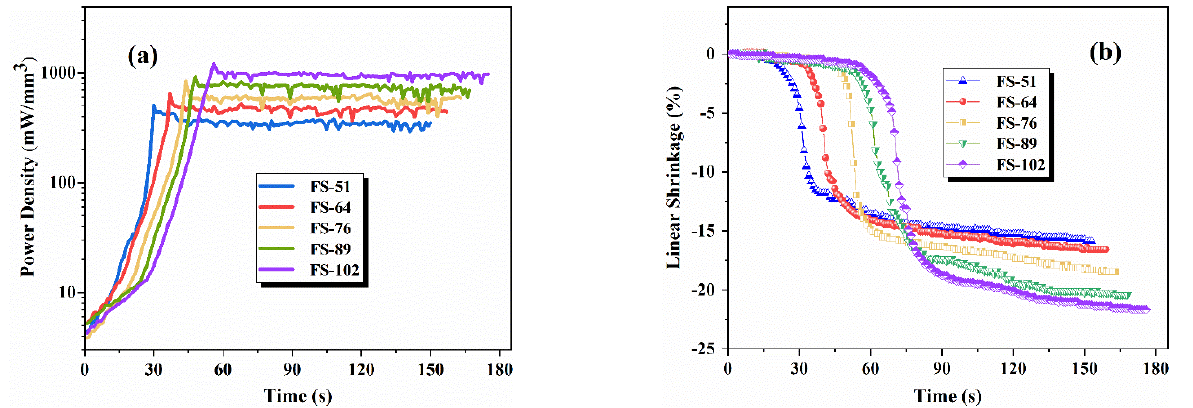
Figure 2. The dependence of ( a ) power dissipation and ( b ) linear shrinkage on time under a constant electric field of 400 V/cm.